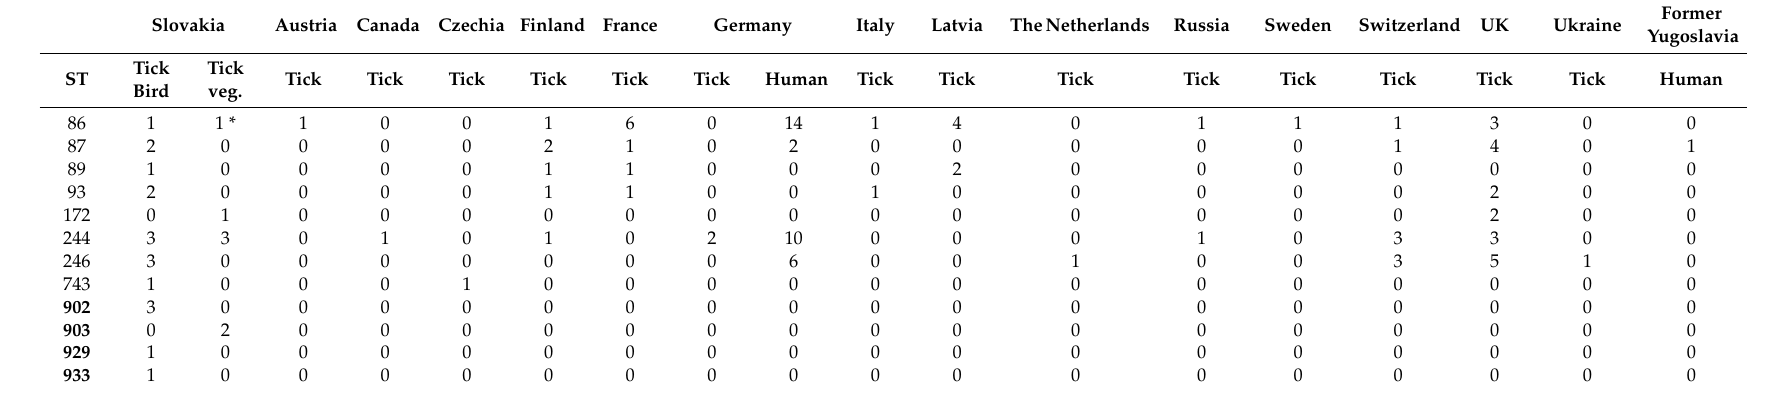
STs detected for the first time in this study are in bold